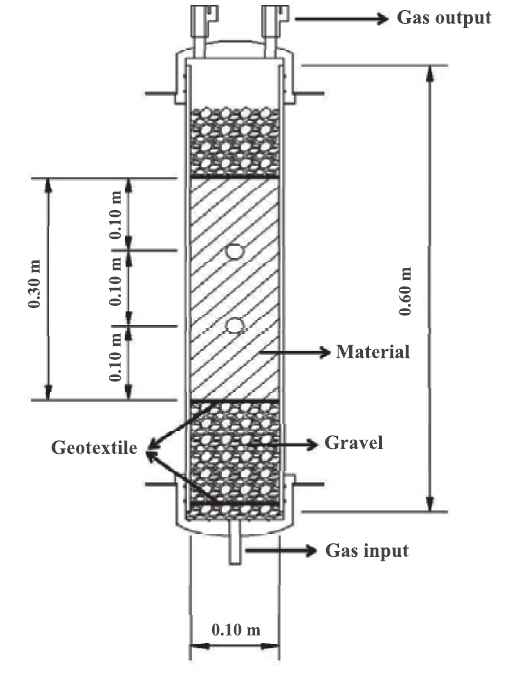
figure 1. diagram of the experimental